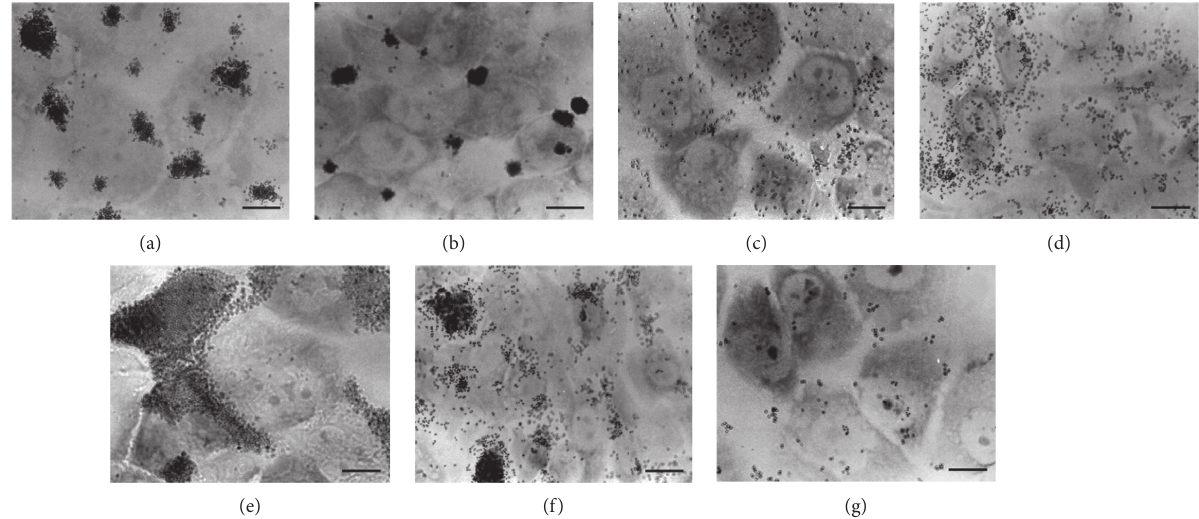
Figure 2: Light micrograph showing the patterns of adherence of reisolates to human conjunctiva cells ((a–g) represent MS11, G29, 4R1, SA, 7uB, 6uF, and V3, resp.). After the 5h adherence assay, nonadherent bacteria were removed by washing three times with sterilized PBS. Cells were stained with a modified Wright stain and viewed under light microscopy. Scale bar: 10 μ